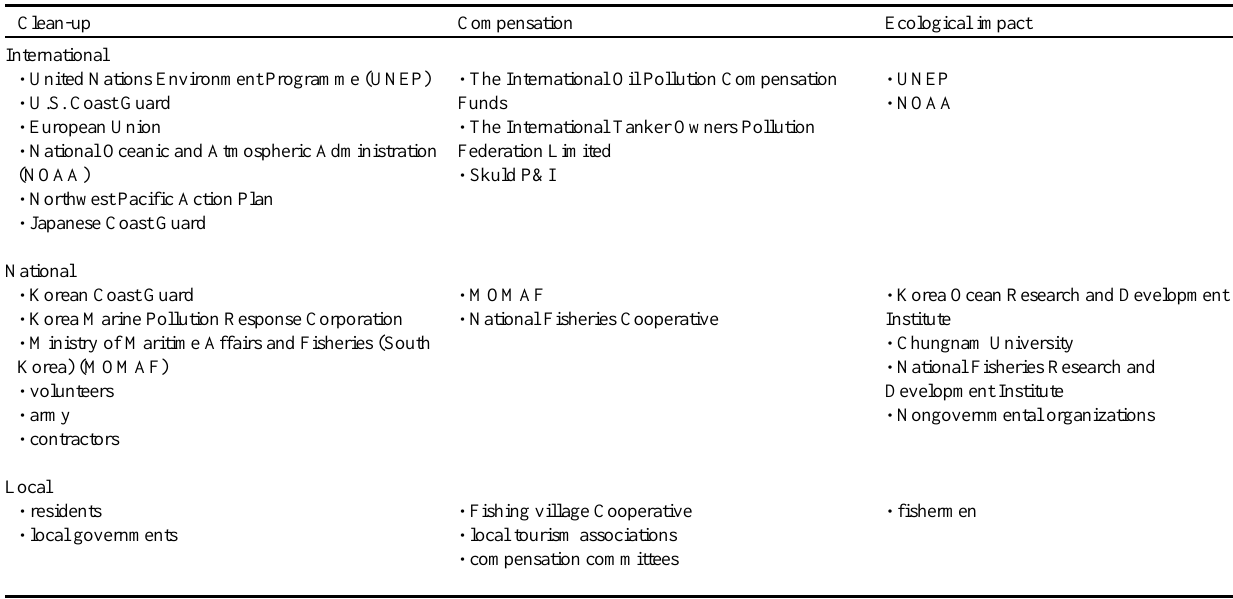
Table 1 . Human Resources: manpower and expertise after the Hebei-Spirit oil spill in South Korea.